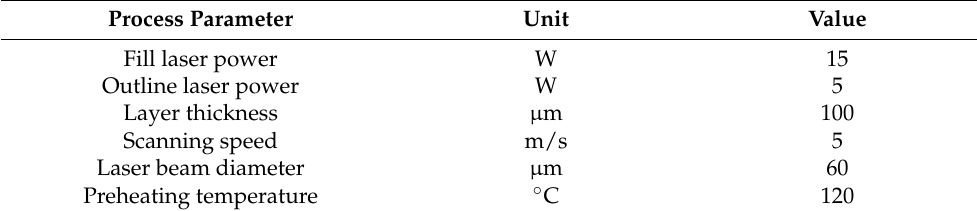
Table 3. Manufacturing parameters of BLDC motor components and